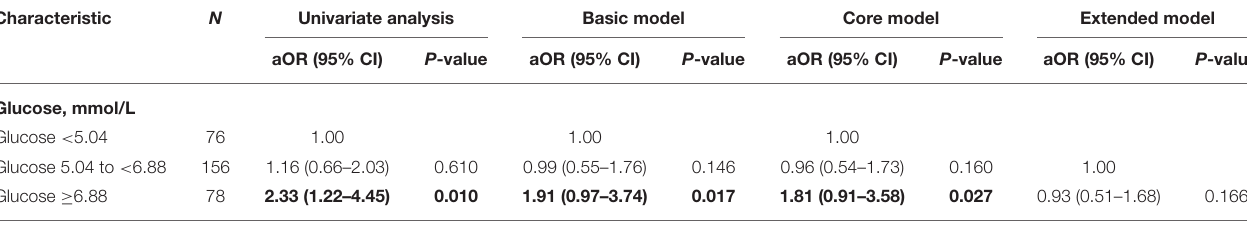
TABLE 3 | Relative risk of having a hospital LOS of > 2 weeks was calculated according to POBG level in tertile groups a . Characteristic N Univariate analysis Basic model Core model Extended